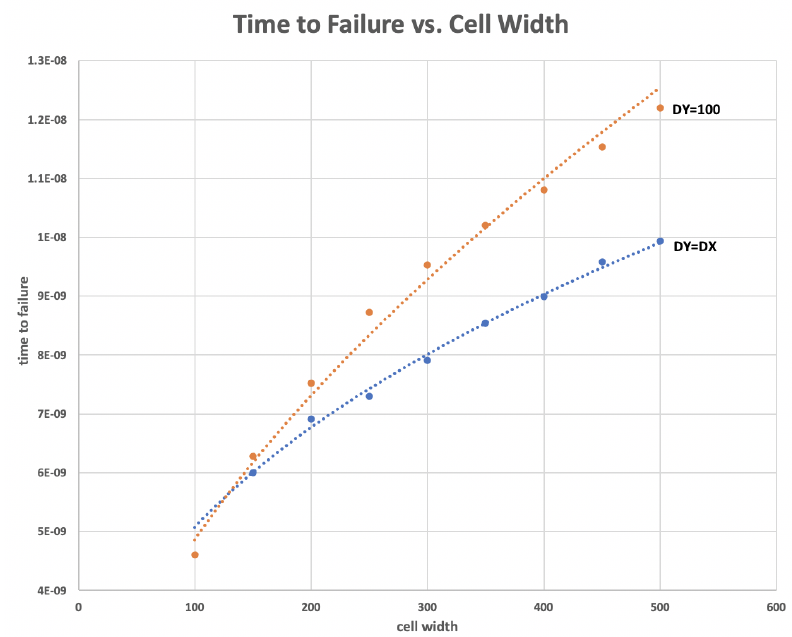
Figure 8. Time of failure is plotted as a function of the cell width DX . The strain rate for all points is ˙ ϵ = 1 × 10 5 s − 1 , the ensemble size is 100 and the process zones is 10% of the crack radius. In the upper curve, DY = 100 µ m for all points. In the lower curve, DY = DX . On both curves, wider cells take longer times to fail. Taller cells take less